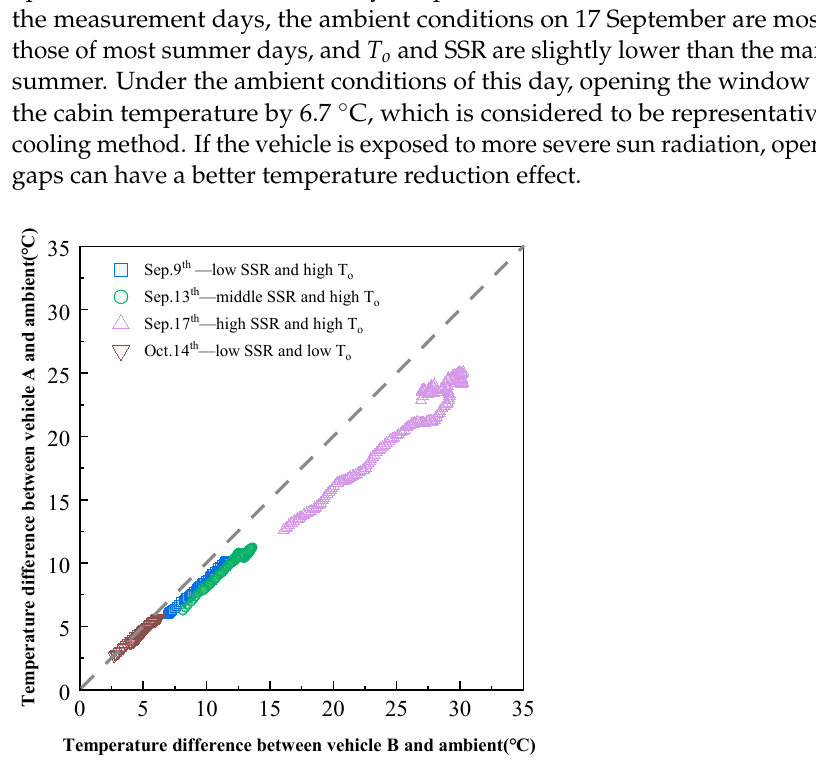
Figure 9. Temperature reduction effect of open-window gaps under different ambient conditions.